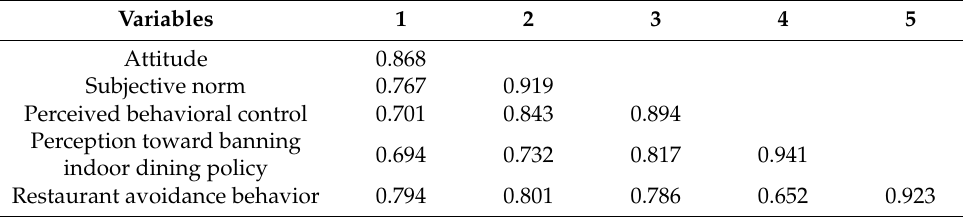
Table 3. Discriminant validity analysis.